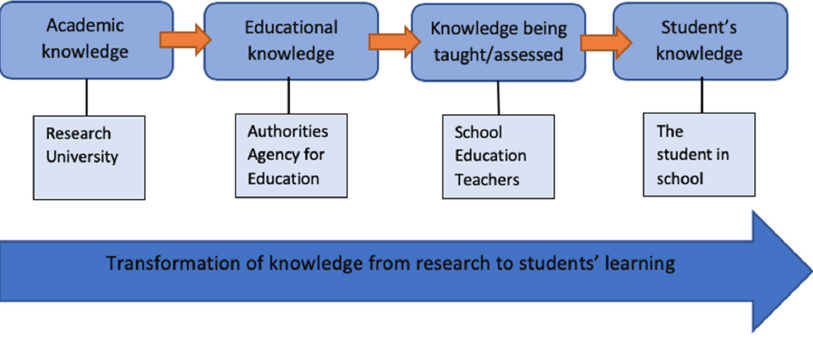
Figure 1. Our illustration of Anthropological Theory of Didactics (Chevallard